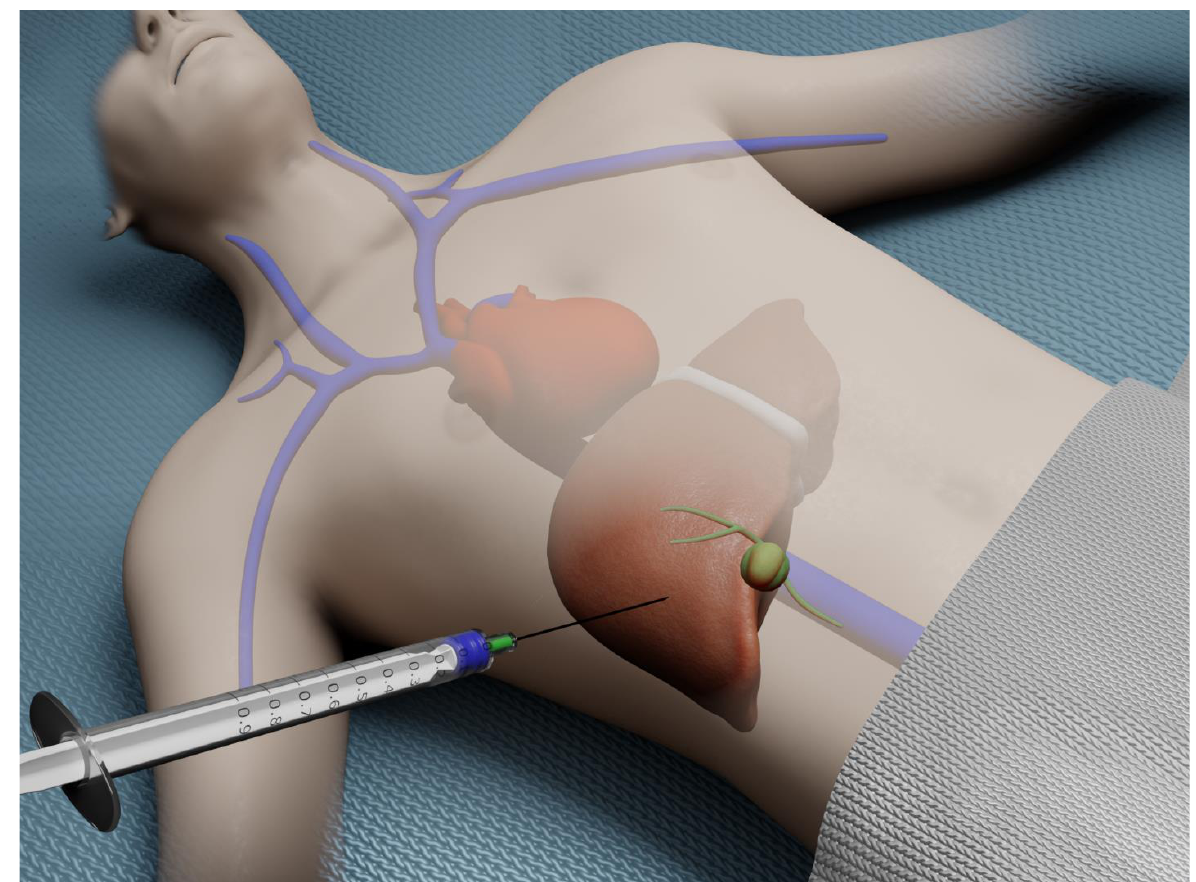
Figure 1. Illustration of bedside percutaneous liver biopsy.